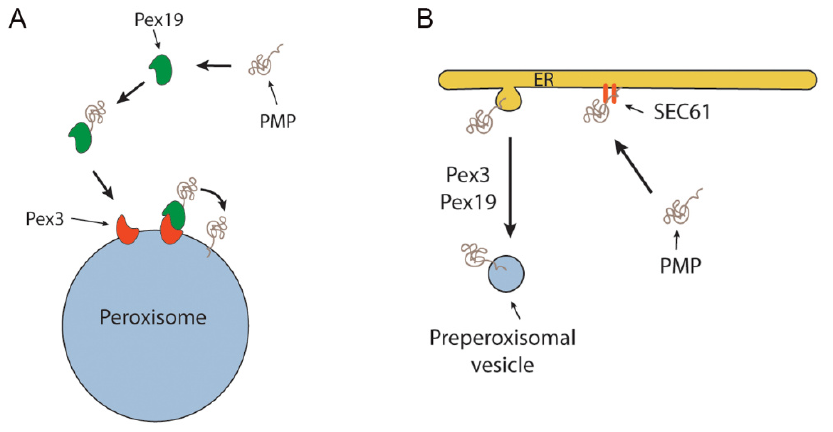
FIGURE 1: Current PMP sorting models.